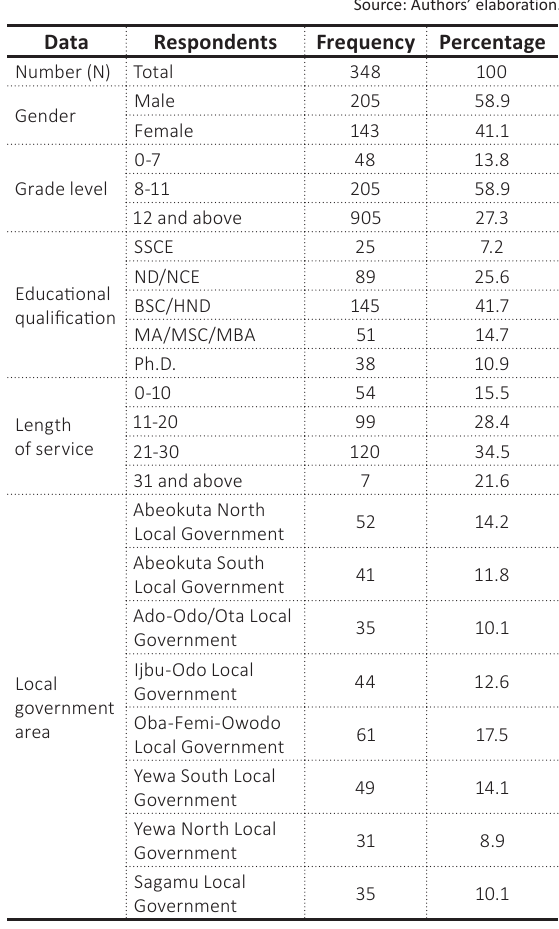
Table 2. Descriptive statistics of respondents